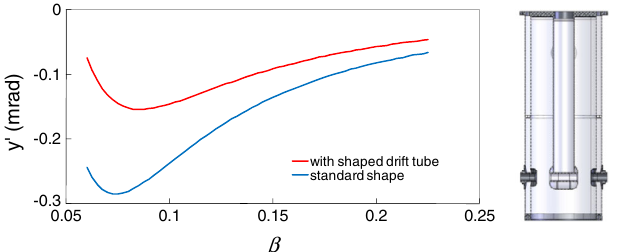
FIG. 7. Left: Magnetic steering in a (cid:1) ¼ 0 : 11 , 141 MHz co- axial QWR at 1 MV = m , A=q ¼ 1 , and (cid:2) ¼ (cid:1) 30 (cid:6) . Blue line: ¼ 0 : 25 ; red line: the same cavity after Normal cavity with G Bx the addition of an axisymmetric ‘‘donut’’ shaped drift tube, ¼ 0 : 16 . Right: Sketch of the resonator with the leading to G Bx modified drift